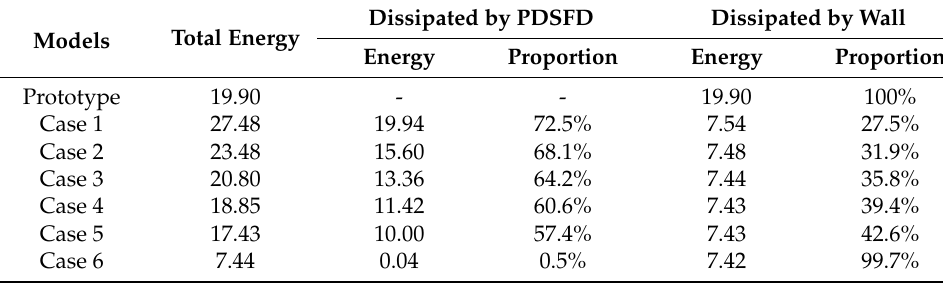
Figure 9. Hysteretic curve of the wall in numerical models. Table 1. Energy dissipation of the numerical models (unit: kJ).